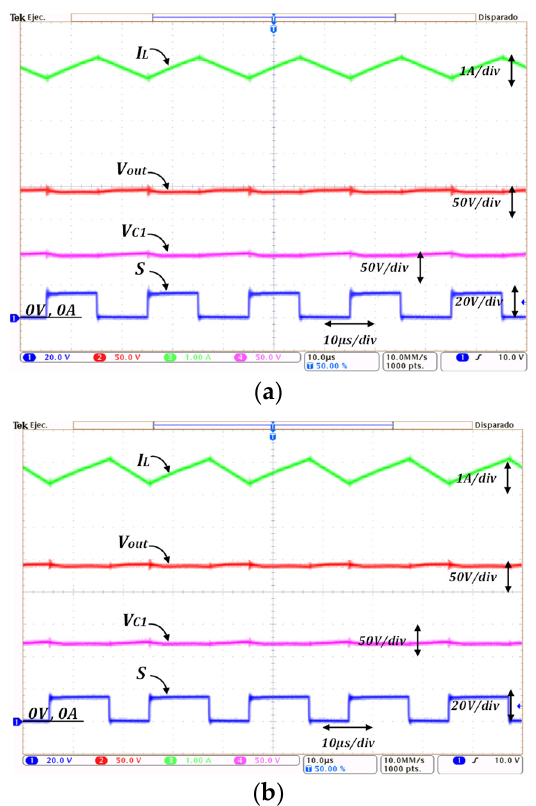
Figure 34. Important waveforms of the converter operation, from top to bottom: the current through the inductor, the output voltage, the voltage across capacitor C 1 and switch voltage. ( a ) For D = 0.5, and ( b ) for D = 0.6.